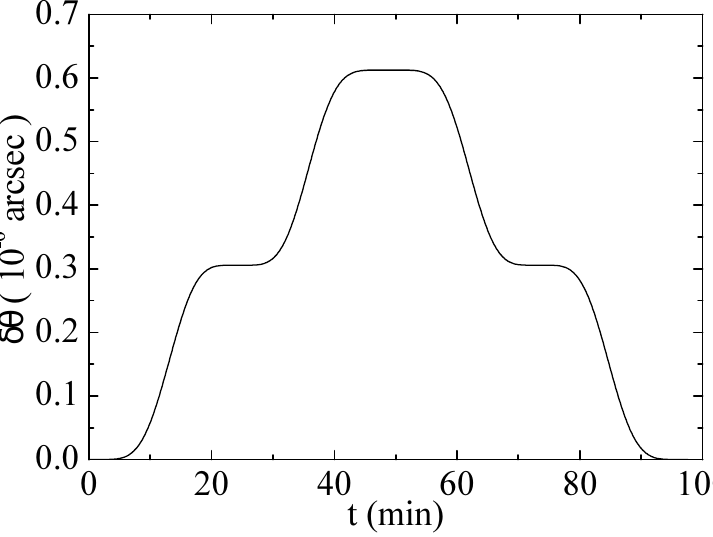
Figure 3. Evolution of the orientation angle of a gyroscope for the Gravity Probe B experiment under the influence of the gravitomagnetic field in Equation (3) for n = 4 , m = 5 and β = 0 . 6824 . The angle, δθ , is measured in units of a millionth of an arcsec and time, t , in